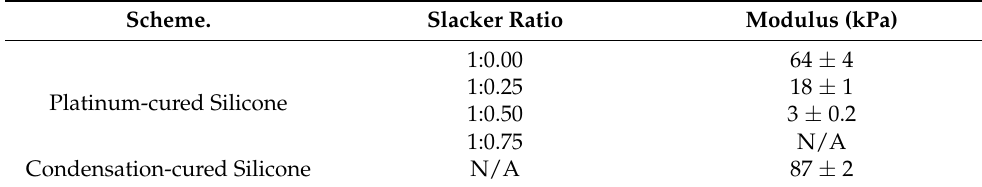
Shear moduli of the platinum-cured and condensation-cured silicone relative to Slacker